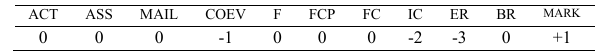
Table 7. FIR optimal mask (fuzzification parameters defined by experts).